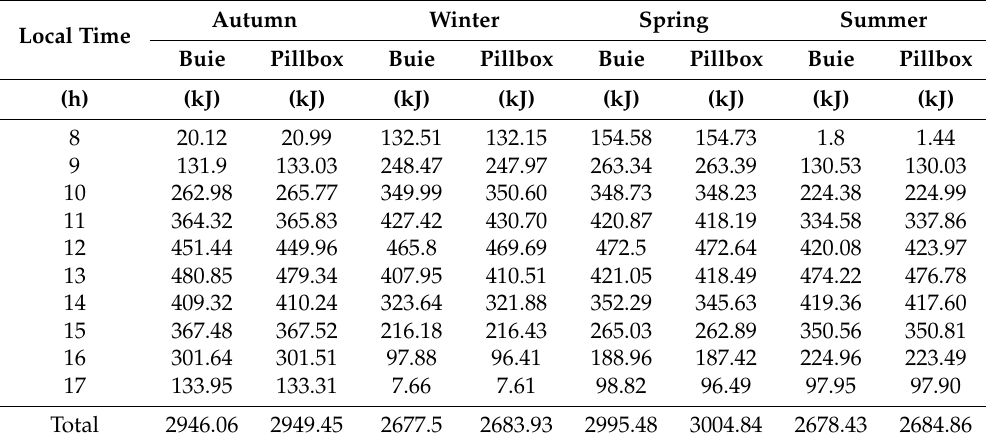
Table 2. Buie and Pillbox comparative sunshape energy for one specific day.